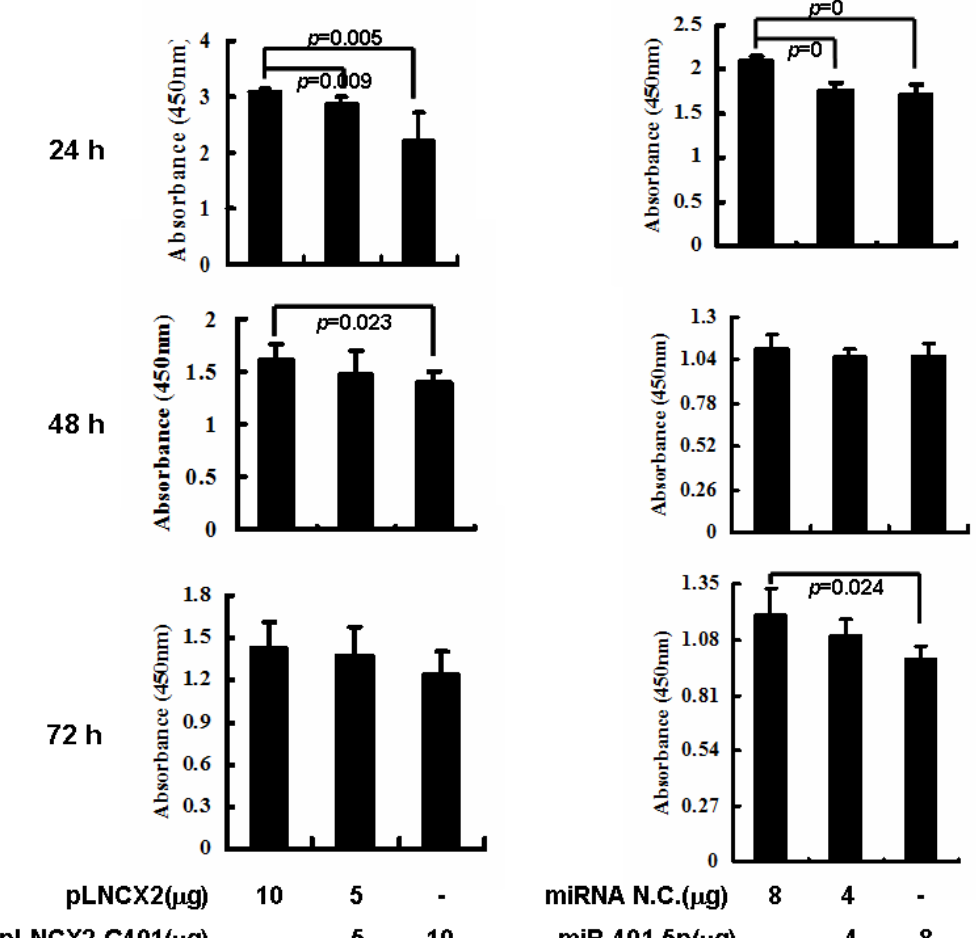
Figure 5. miR491-5p inhibited the proliferation of pancreatic cancer cell line SW1990. SW1990 cells were transfected with increased doses (0, 5 and 10 μ g) of miR491-5p for 24, 48 and 72 h. At each time point, the transfected cells were collected and assayed by CCK-8 kit. The proliferation rates were measured at 450 nm with a plate reader. The values represented as the mean ± SD from six independent experiments for each dose at each assay point, that were subjected to student’s t test alaysis. The experiment included the empty vector (pLNCX2) transfected sample as a standard control. Difference